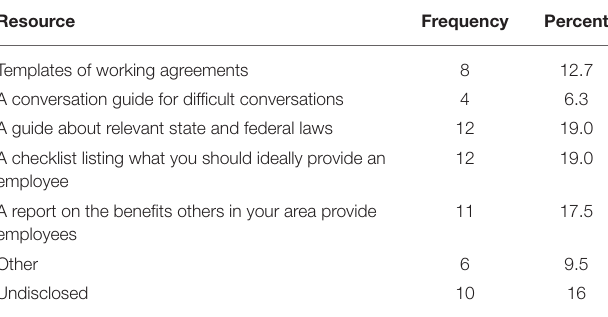
TABLE 5 | Resources for